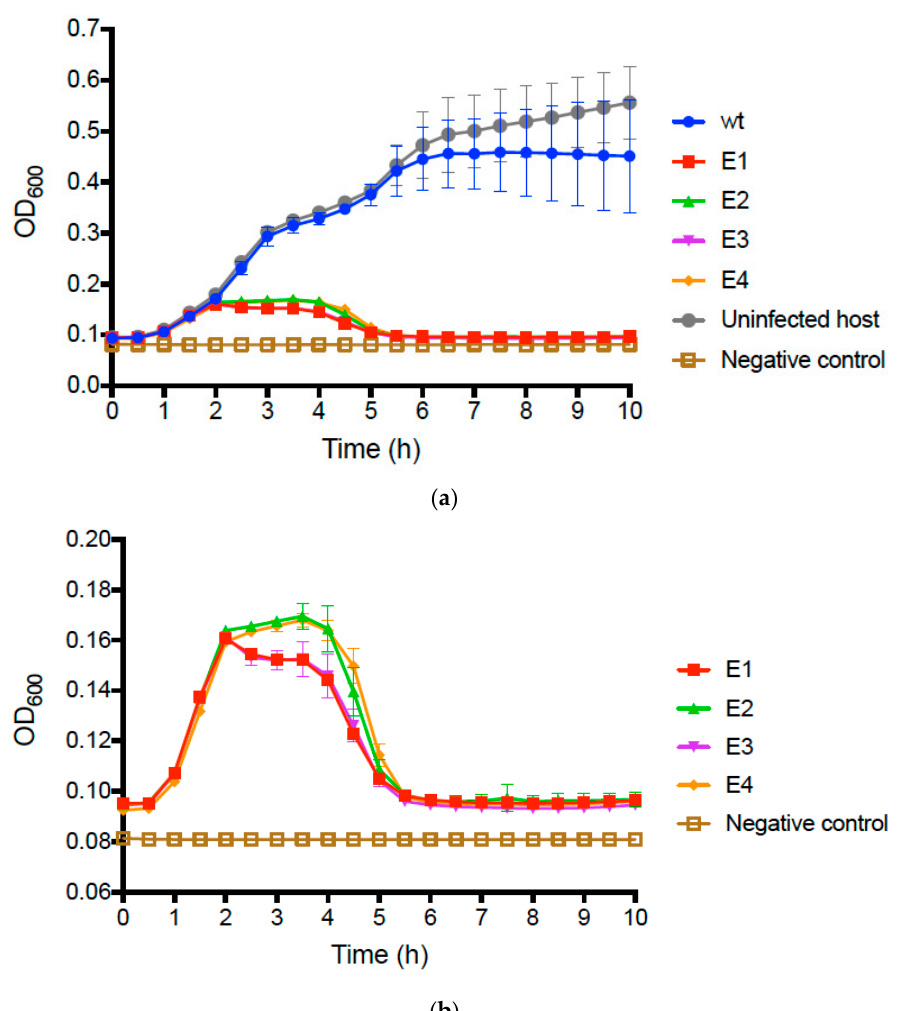
Figure 2. ( a ) Growth of E. coli O157:H7 cells infected with wt ancestor (phage PP01), and with each evolved phage population (E1–E4) at MOI = 0.01. Controls consisted of uninfected cells, and a negative control of media without added cells or phage. ( b ) Subset of the data in panel Figure 2a, presented at higher magnification to highlight negative effects of evolved phage populations on growth of E. coli O157:H7 cells. In both panels, error bars represent 1 standard deviation ( n = 3); error bars too small to be seen are omitted from the graph.